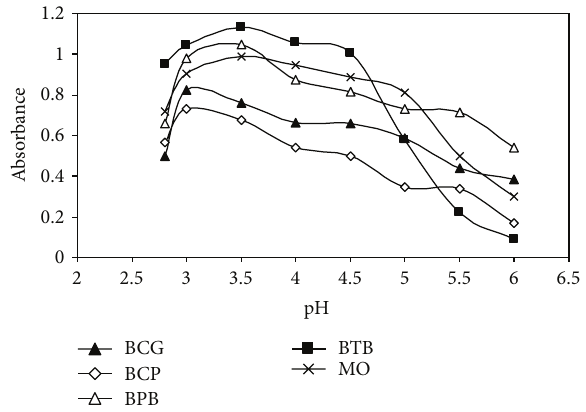
Figure 1: Effect of pH of acetate buffer solution on ion-pair complex formation between GMF and (1.0 × 10 −3 M) reagents.